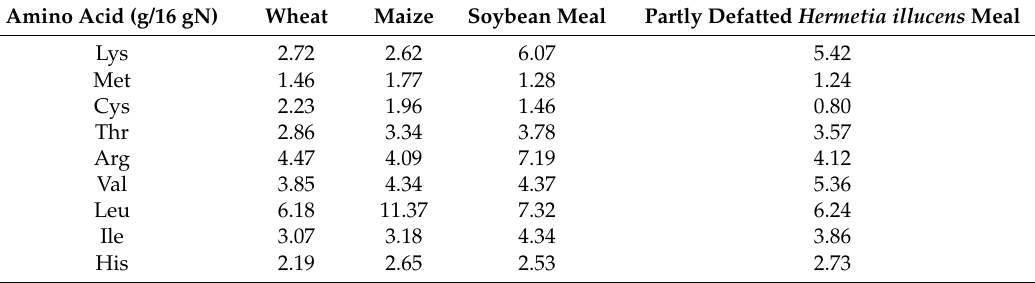
Table 1. Analyzed amino acid content of the main feed ingredients (g/16 gN). Amino Acid (g/16 gN) Wheat